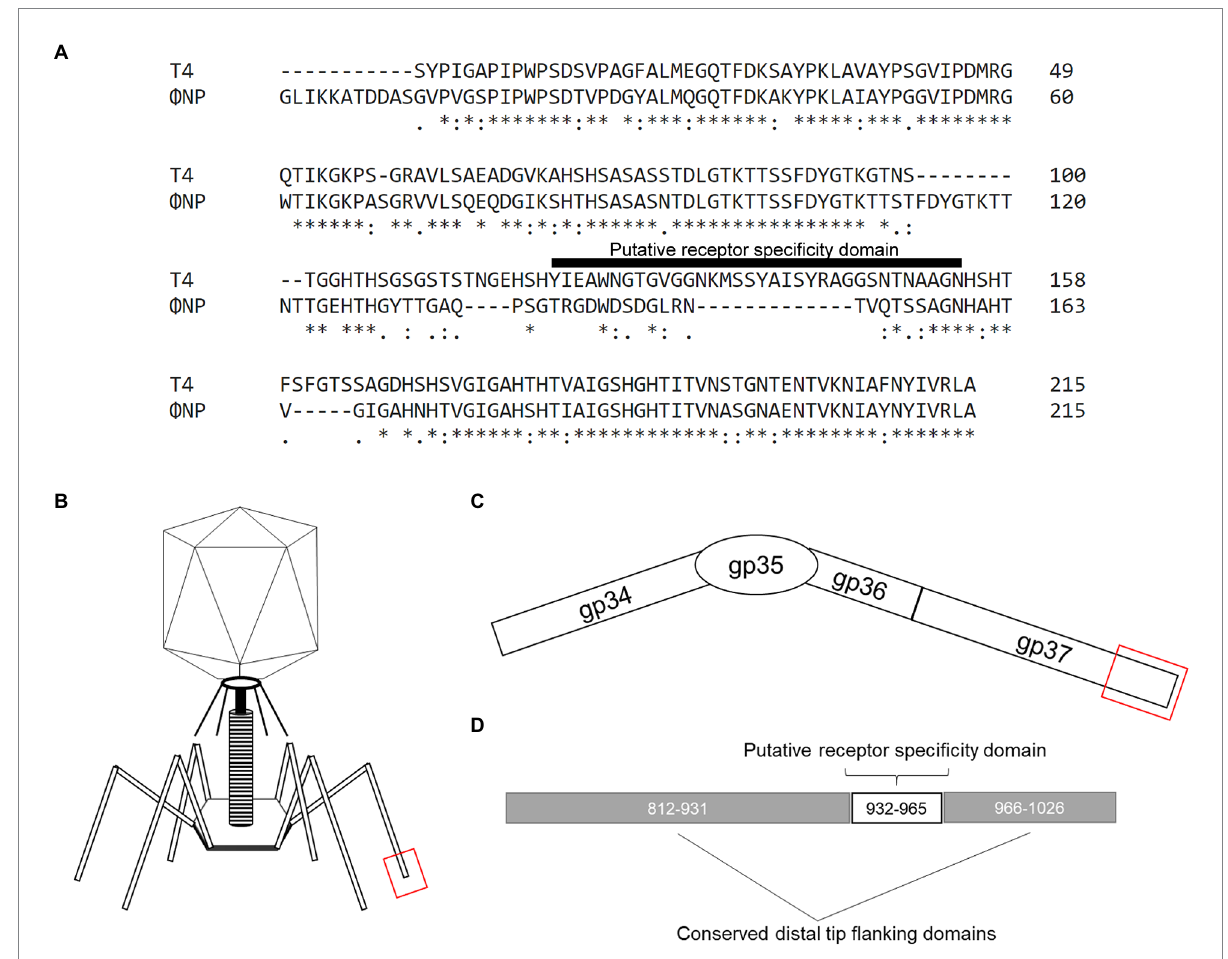
FIGURE 1 The previously uncharacterized open reading frame 6 (ORF6) of the Citrobacter rodentium temperate phage, Φ NP, shares high similarity with the known T4 RBP (gp37). (A) Amino acid (AA) alignment by ClustalOmega depicting high similarity between Φ NP ORF6 and the distal 215 AAs of the 1,026 AA-long known T4 RBP (gp37). Note, primary sequence dissimilarity is found at the same site as the putative receptor specificity domain (here noted as T4 AA position 120–154) of gp37. (B) A cartoon depicting the structure of a bacteriophage T4 virion. (C) A schematic of the bacteriophage T4 tail fiber. The tail fiber is composed of the protein products of gp34, gp35, gp36, and gp37. The RBP element of phage T4 specificity has been isolated to the interaction of gene product gp37’s distal end and bacterial surface protein OmpC. (D) A schematic noting the distal 215 AA of gp37 with conserved distal tip flanking domains (AA 812–931 and 966–1,026; as conserved in ORF6 of Φ NP) and putative receptor specificity domain (AA 932–965 of